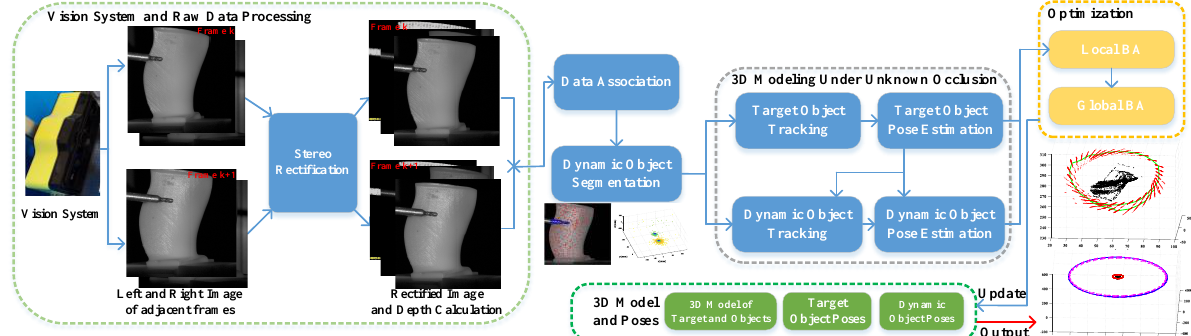
Figure 1. An illustration of our pipeline. (1) Vision system captures left and right images. Stereo rectification is first performed to align the epipolar lines of the left and right images by rotating two images. The depth of the points can be calculated by disparity. (2) When two consecutive frames arrive, data association is established by Grid-based Motion Statistics (GMS) and image block correlation. Then, object segmentation is carried out by random sampling and pose hypotheses clustering. (3) The segmentation results, which include initial poses and 2D-3D point pairs, are sent to the 3D modeling part. It includes the target object tracking module and the dynamic object tracking module. The target object poses (namely, camera pose) and the dynamic object motions will be estimated and optimized. (4) Finally, local BA and global BA are carried out to optimize and update these variables. The outputs of our pipeline are poses of target and dynamic objects, a 3D model, and 3D point cloud of dynamic objects.